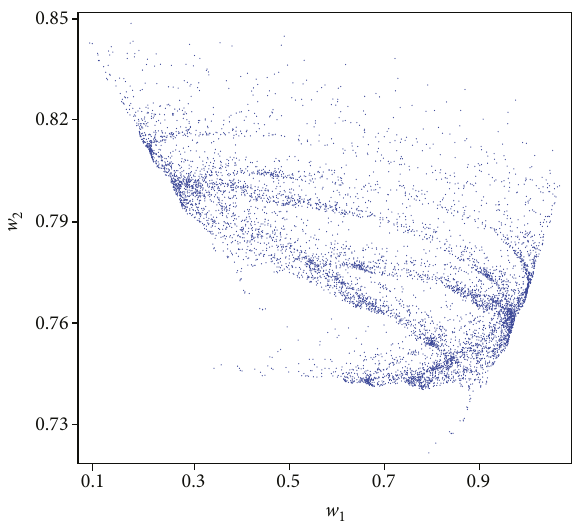
Figure 18: The chaotic attractor of w